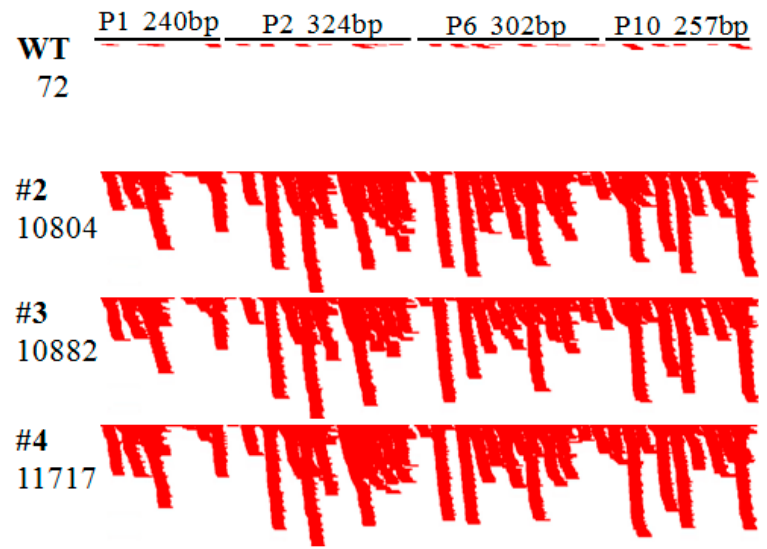
Figure 4. Distribution of the hpRNA-derived siRNAs across the four sequence fragments of the fusion viral sequence from the genes encoding P1, P2, P6 and P10. WT, wild-type Kitaake; #2, #3 and #4, three independent transgenic rice lines resistant to RBSDV.